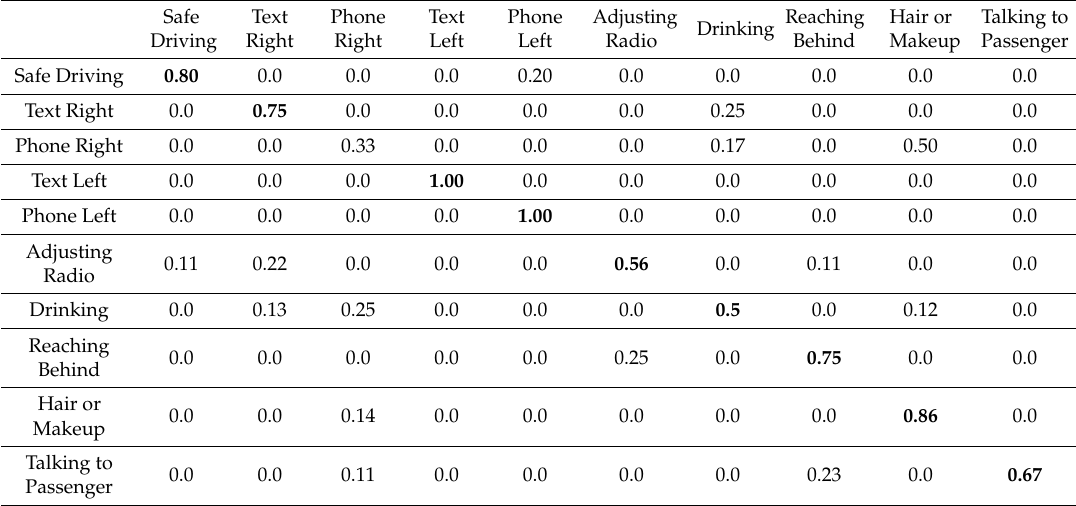
Table 3. Confusion matrix in the self-compiled